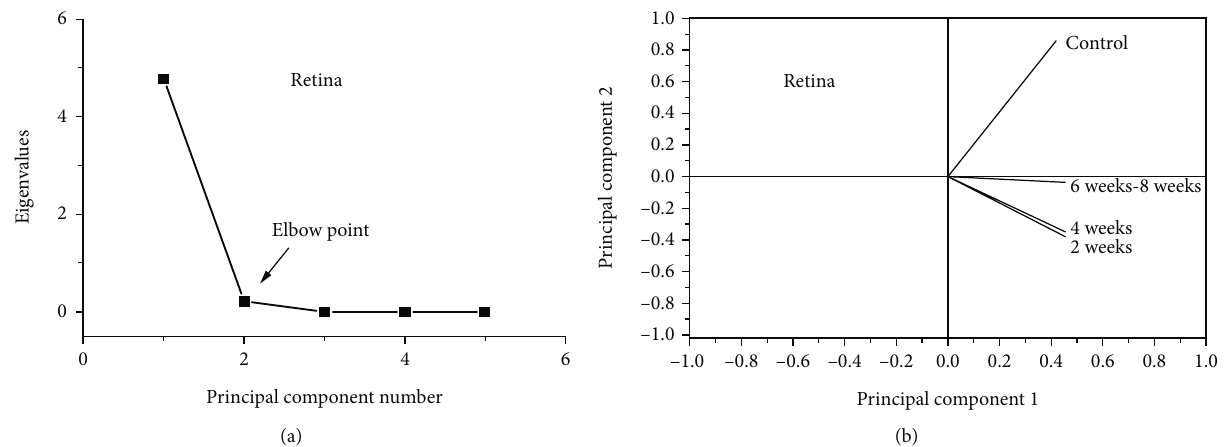
Figure 5: (a) Eigenvalues in relation to the principal components of FTIR data and (b) the loading plot for retinal amide I data.